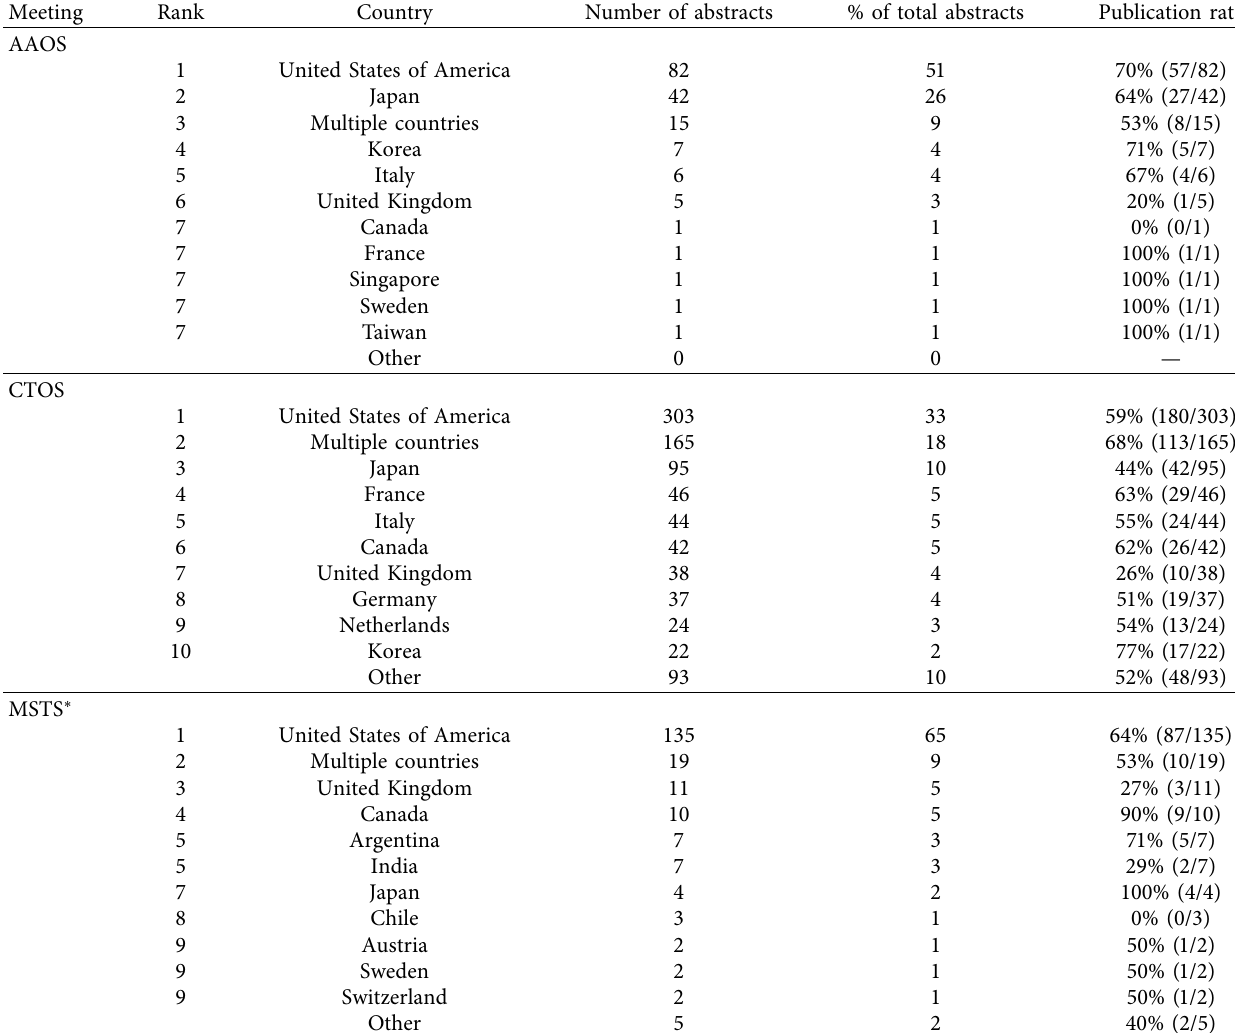
Table 3: Top ten countries with most abstracts from select AAOS, CTOS, and MSTS annual meetings. Meeting